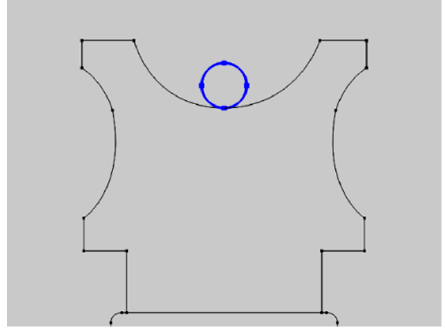
Figure 9. Terminal voltage of 20 kV on insulator model.